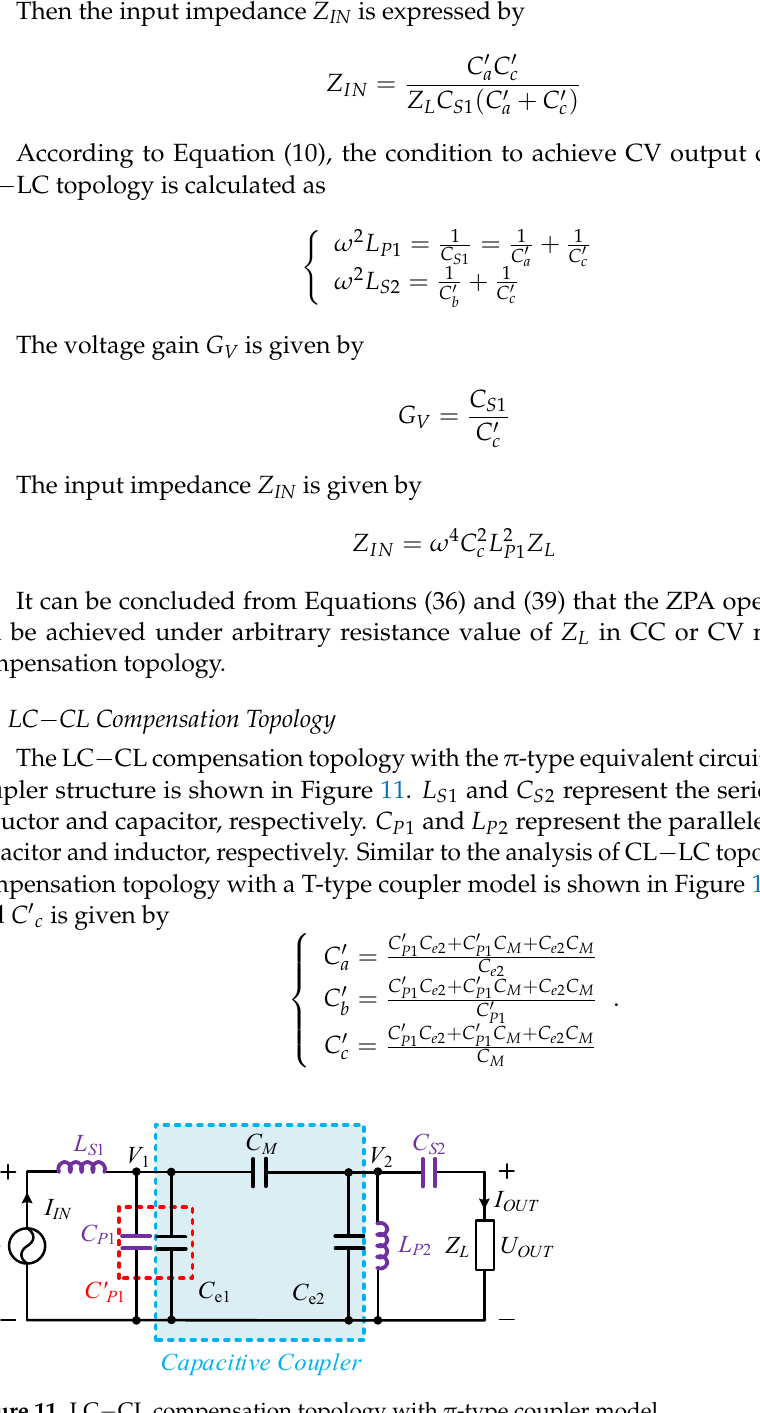
Figure 11. LC − CL compensation topology with π -type coupler model.